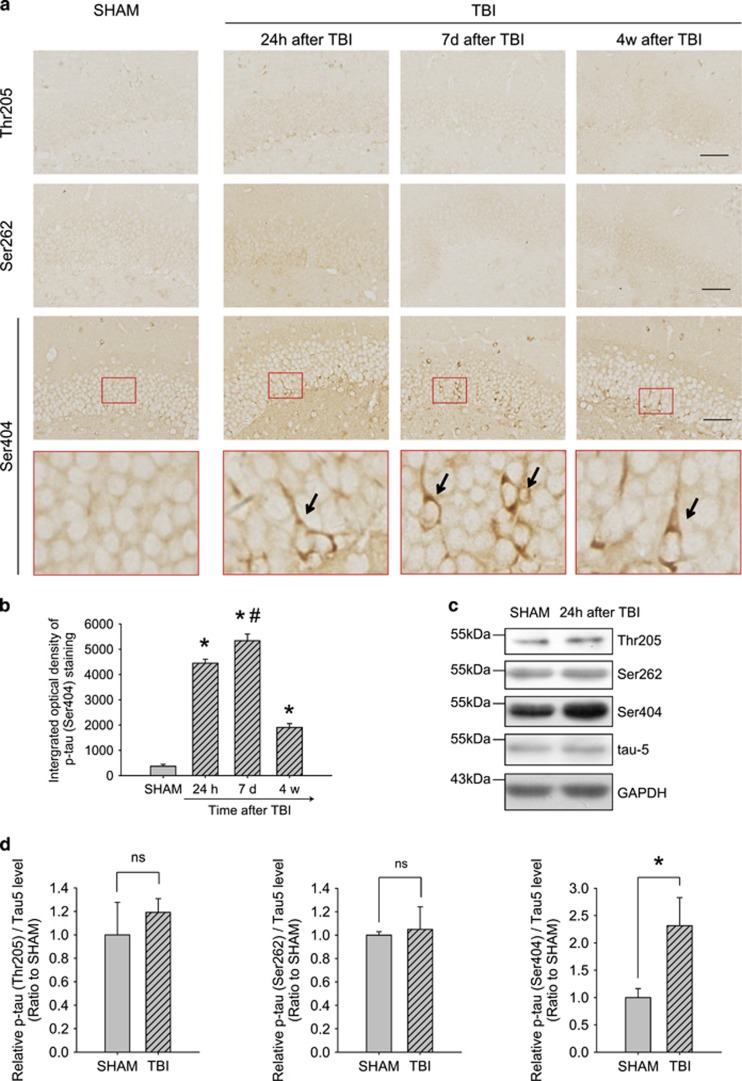
Hyperphosphorylation of tau in wild-type mice after traumatic brain injury (TBI). (a) The contralateral dentate gyrus (DG) showed a significant increase in the level of tau phosphorylated at Ser404 at 24 h, 7 days and 4 weeks post-injury. The levels of tau phosphorylation at Thr205 and Ser262 did not change obviously. Scale bar, 50 μm. (b) The integrated optical density of Ser404 phospho-tau staining in the contralateral DG of SHAM mice and mice 24 h, 7 days and 4 weeks after TBI. n=3 per group. Data represent mean±s.e.m., *P<0.05 compared to the SHAM group, #P<0.05 compared to the 24 h group, one-way ANOVA. (c) Western blot analysis indicated that only phosphorylation at Ser404 increased at 24 h after TBI. (d) Relative levels of phospho-tau/total tau based on western blot results for the contralateral hippocampus at 24 h after TBI; n=3 per group. Data represent mean±s.e.m., *P<0.05 between the two groups, two-tailed t-test.